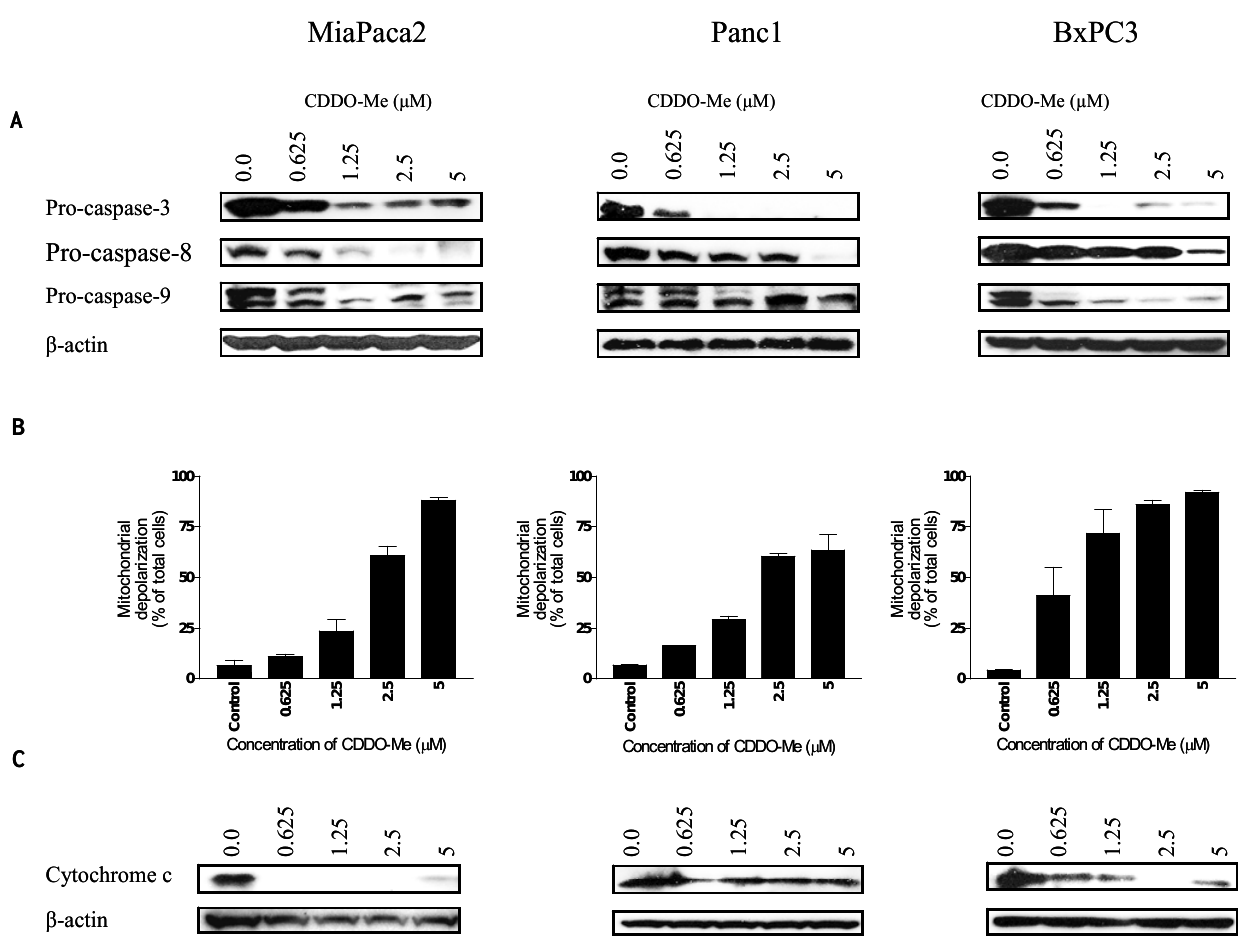
Figure 3. Effect of CDDO-Me on procaspases and mitochondrial integrity. MiaPaca2, Panc1 and BxPC3 cells were treated with CDDO-Me at 0.625 to 5 µM for 24 h and analyzed for the cleavage of procaspase-8, -3, -9 ( A ), mitochondrial depolarization ( B ) or release of cytochrome C from mitochondria ( C ). Similar results were obtained in two separate